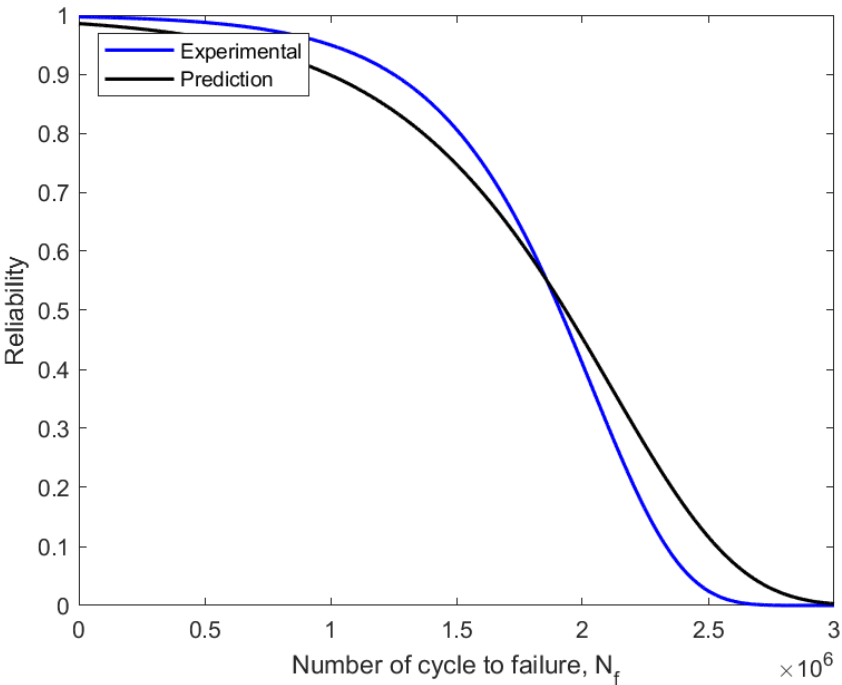
Figure 15. Reliability curve using experimental and predicted fatigue data.